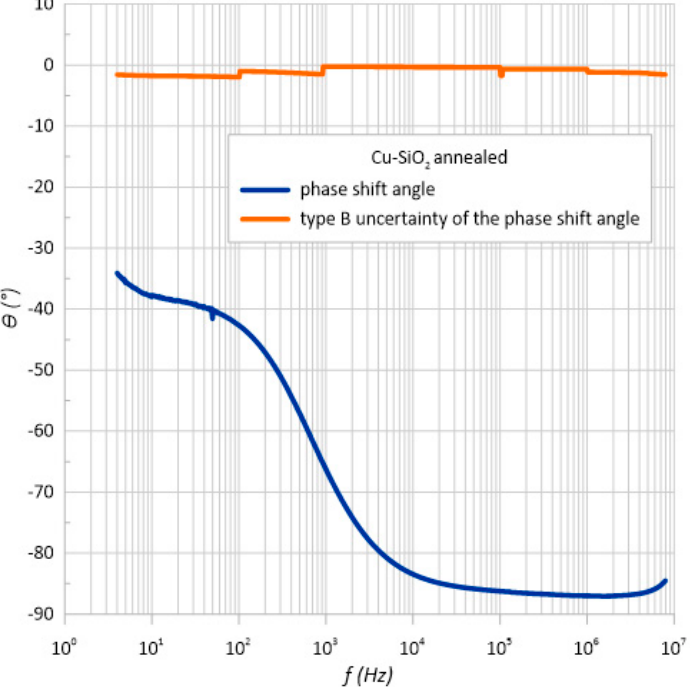
Figure 15. Frequency dependence of the impedance and standard impedance uncertainty of meas- urement type B u ( θ ) of the heated structure.